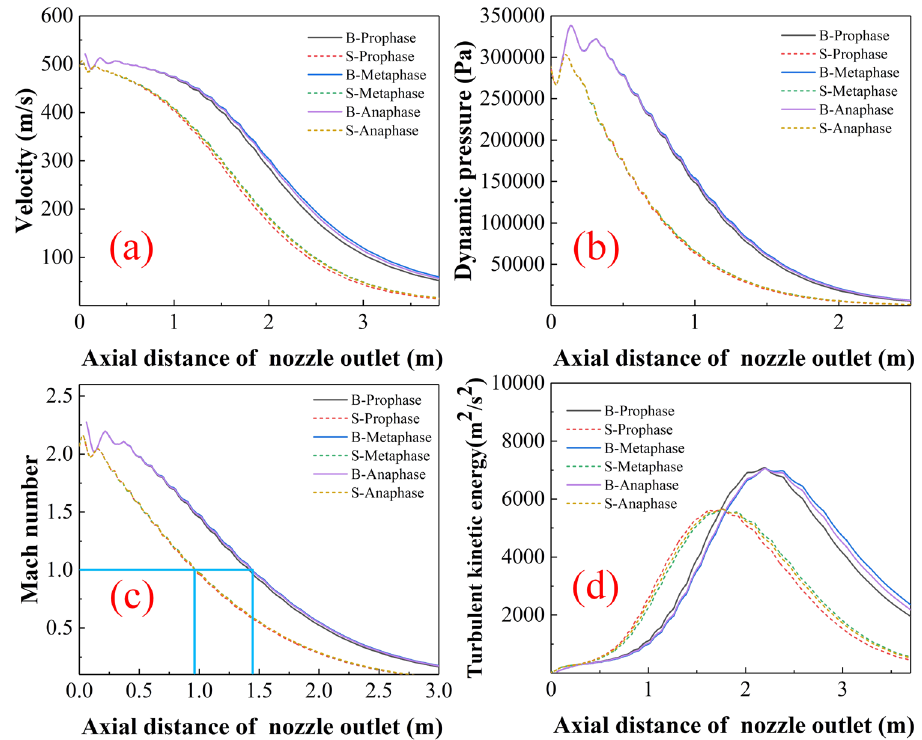
Figure 9: Jet characteristics of the nozzle axis under di ff erent atmosphere conditions: ( a ) velocity, ( b ) dynamic pressure, ( c ) Mach number, and ( d ) turbulent kinetic